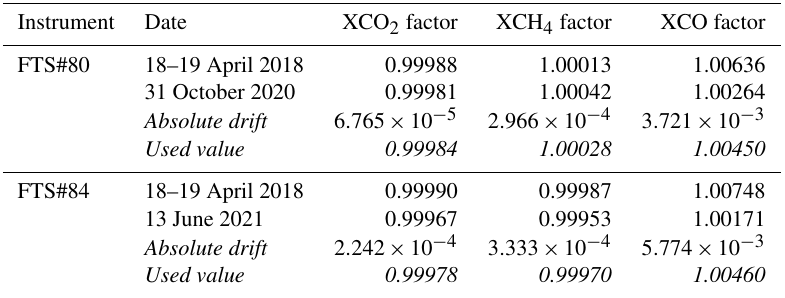
Figure 1. Side-by-side measurements before the instruments were shipped to Russia. Comparisons between instrument no. 1 (FTS#37), which is the COCCON reference unit operated at KIT, and instruments FTS#80 and FTS#84. Table 2. Correction factors for instruments FTS#80 and FTS#84. The italicized values show the small drift of the instruments and the used values on the